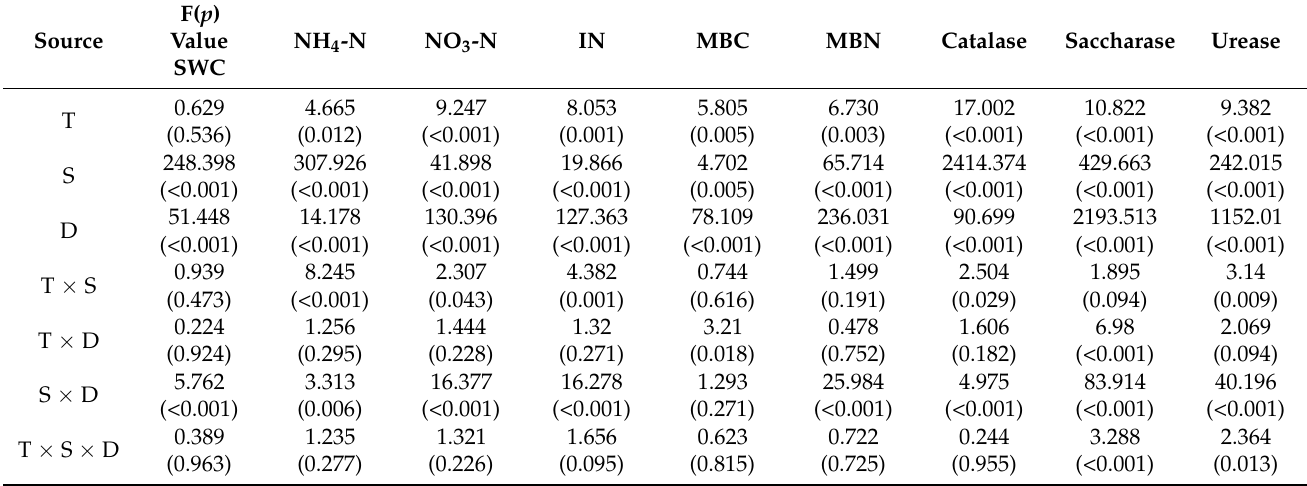
Table 3. F and p values for the effects of pruning treatments (T), sampling seasons (S) and soil depths (D) on the soil properties from repeated measures